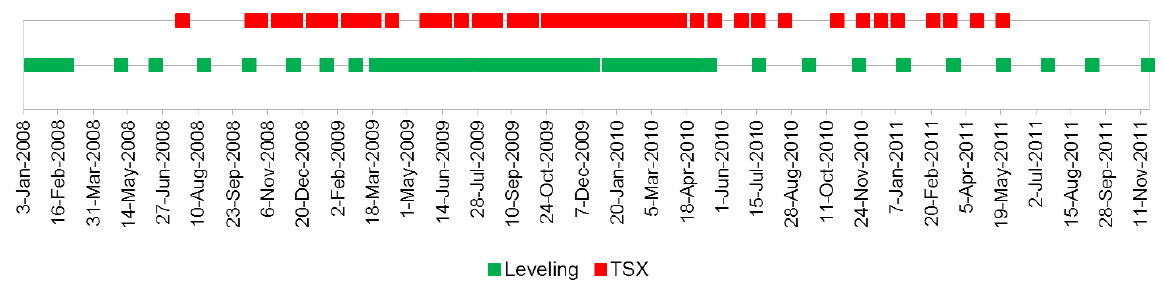
Figure 4. Timeline of the leveling surveys and the available TerraSAR-X satellite (TSX)